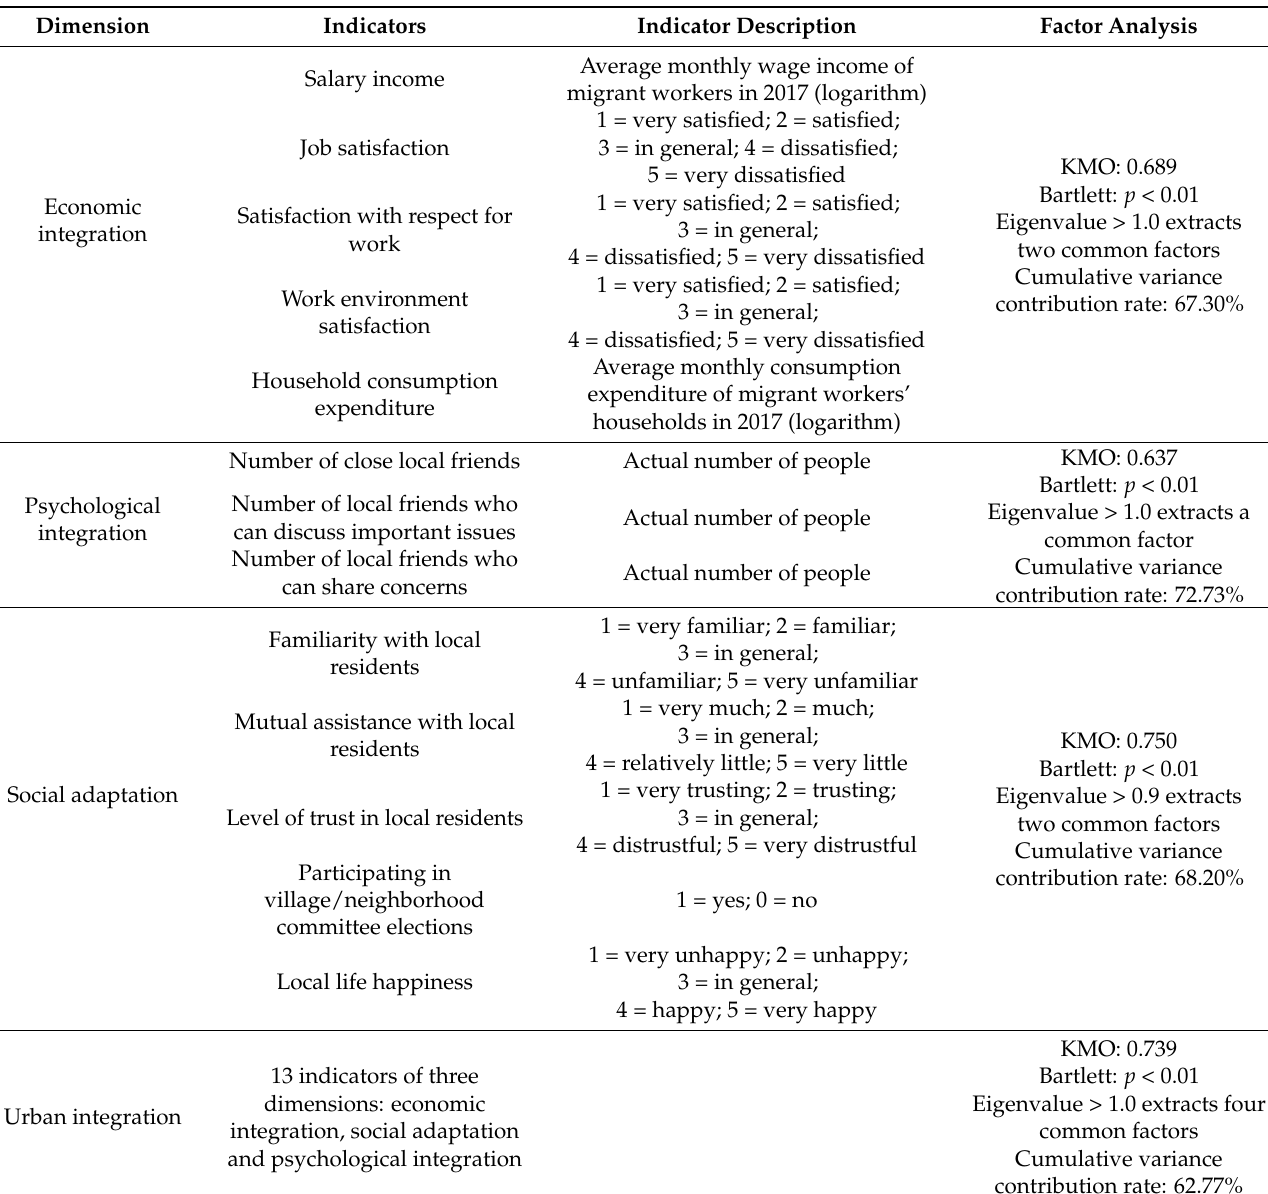
Table 1. Indicator description of urban integration and factor